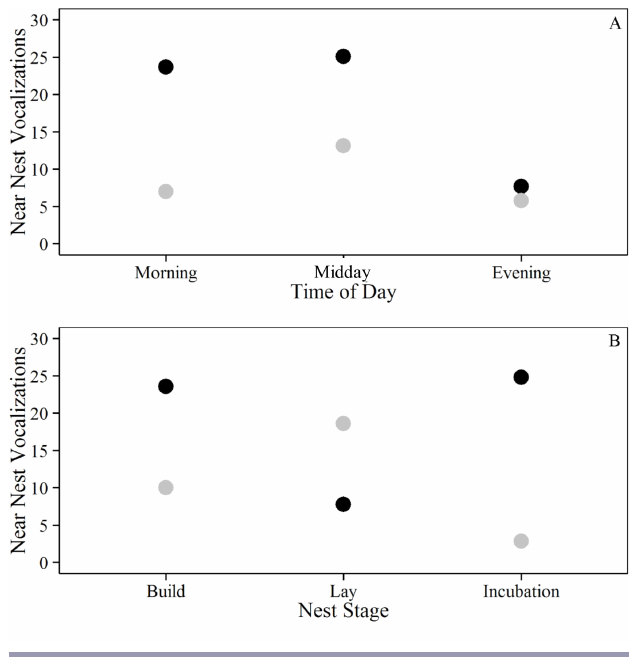
Fig. 4 . Parasite-assessment hypothesis: local cowbird density. Interaction means from the best model of “near-nest” vocalizations by male vireos in central Texas, 2013–2014, considering cowbird density and (A) time of day and (B) nest stage. Vocalizations in areas with high cowbird density are indicated in black, low cowbird density in gray. Standard errors are all too small to display accurately (all SE are <0.22).